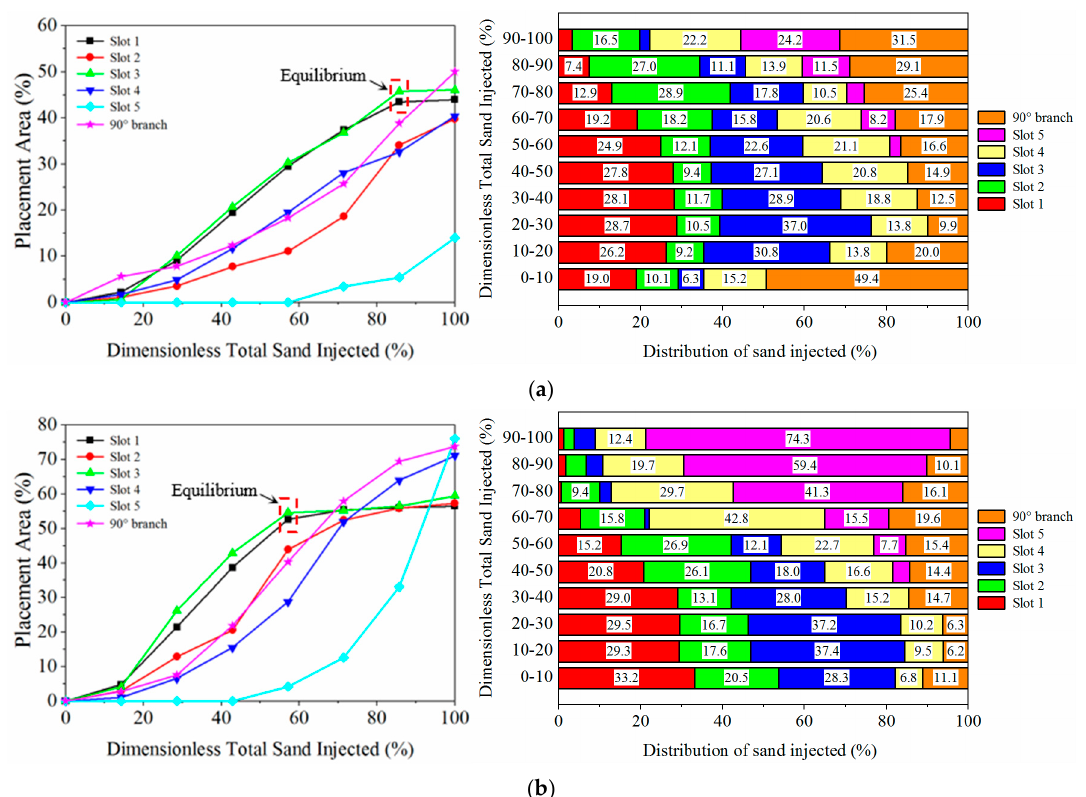
Figure 5. Evolvement of the dunes under different sand ratios, ( a ) case 5 under a sand ratio of 4%, ( b ) case 6 under a sand ratio of 8%.